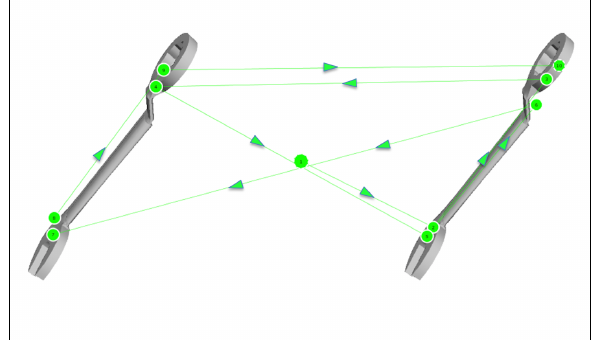
Figure 6: Gaze Pattern 4 - Uncertain Frequency of the gaze patterns for the items wrench and brush. Figure 7 shows the frequencies of the four gaze patterns separately for the items wrench and brush and for the different angles. It can be seen that gaze pattern 1 and 3 were used most frequently for both items. Looking at the two items separately it can be noticed the for the wrench, a dominance of gaze pattern 3 can be found, which is used the most often for all angles. The second most frequently used gaze pattern with the wrench is gaze pattern 1, particularly used with the angles 0°, 45°, 270° and 315°. At the angle of 135°, however, the gaze patterns 1, 3 and 4